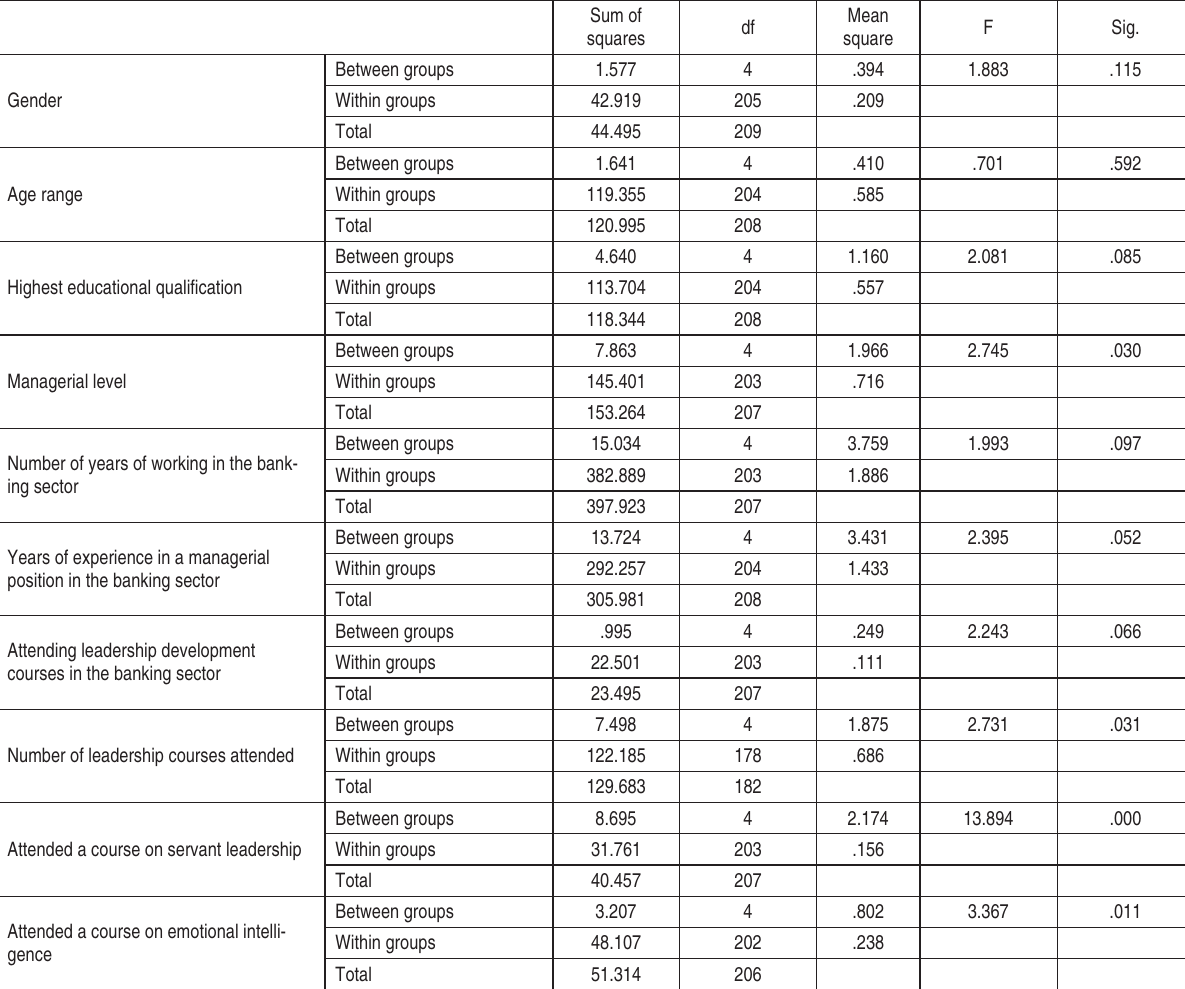
Table 3. ANOVA analysis – servant leadership